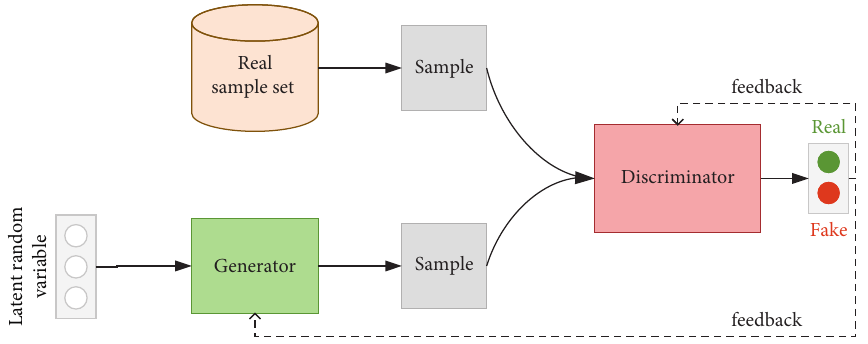
Figure 1: The topology of the generative adversarial network.